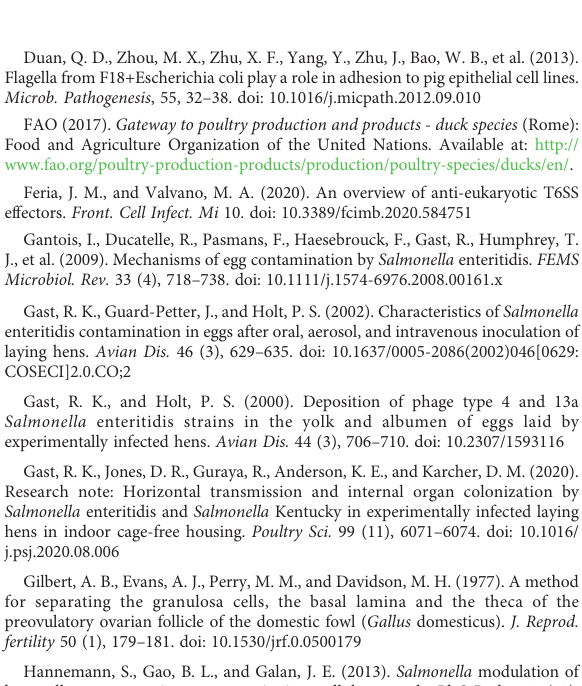
SUPPLEMENTARY FIGURE S1 Identi fi cation of MY1 △ hcp mutants by PCR. M: DL2000 marker, 1: PCR products of combination of cat gene in plasmid pKD3 with hcp homology extension, 2: MY1, 3: MY1 △ hcp ::cat, 4: MY1 △ hcp .